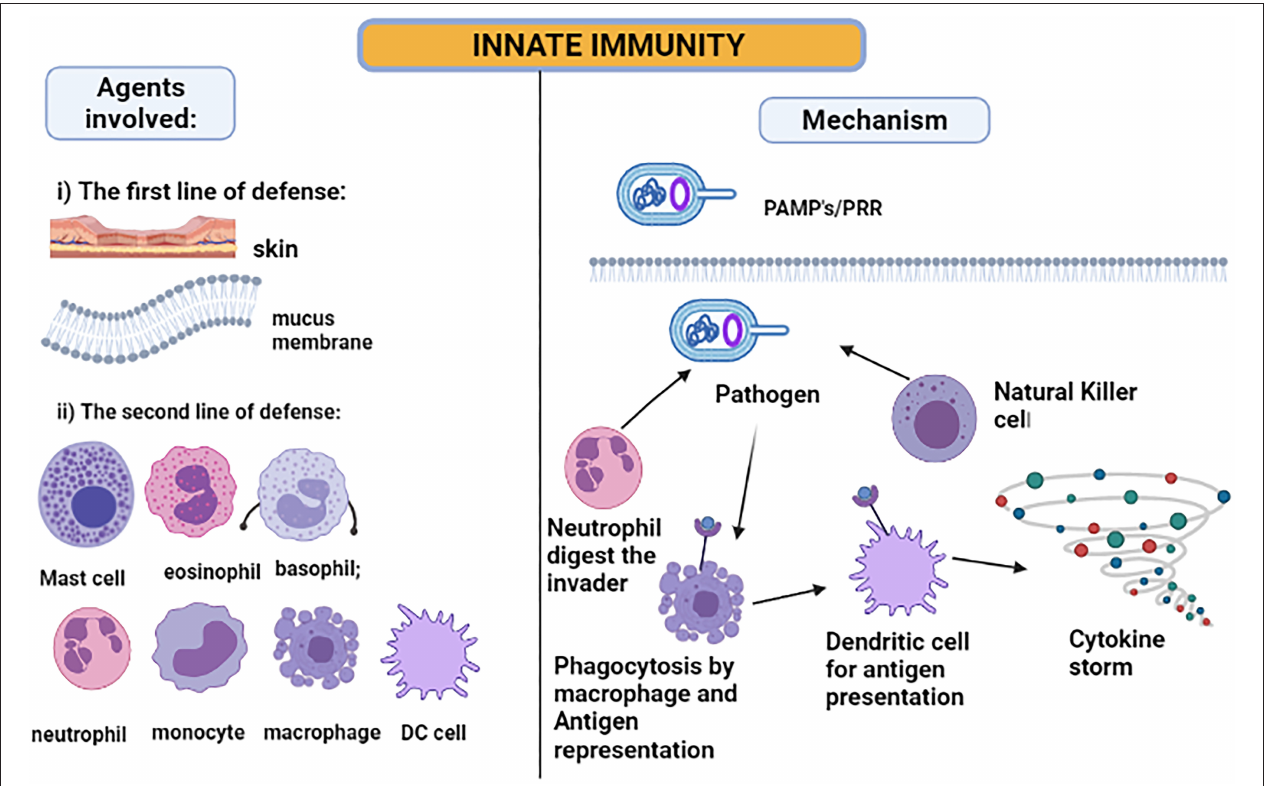
FIGURE 3 | Innate immunity: pathogen-associated molecular patterns are recognized by Toll-like receptors. When the pathogen invades the host cell, the neutrophil and natural killer cells start digesting the pathogen. However, the macrophages and DC phagocytose the pathogen and act as antigen-presenting cells, producing a cytokine storm for attracting other immune cells to amplify the